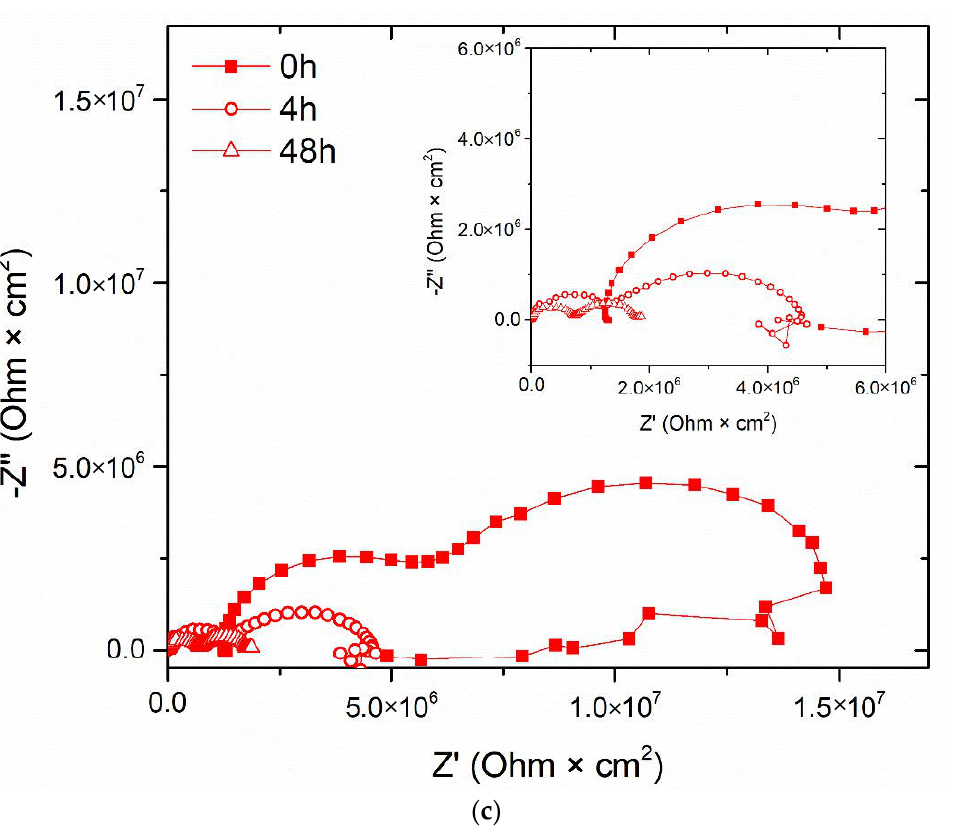
Figure 10. Nyquist diagram evolution during the first 48 h of test of the samples A ( a ), A1 ( b ), and A2 ( c ), respectively.